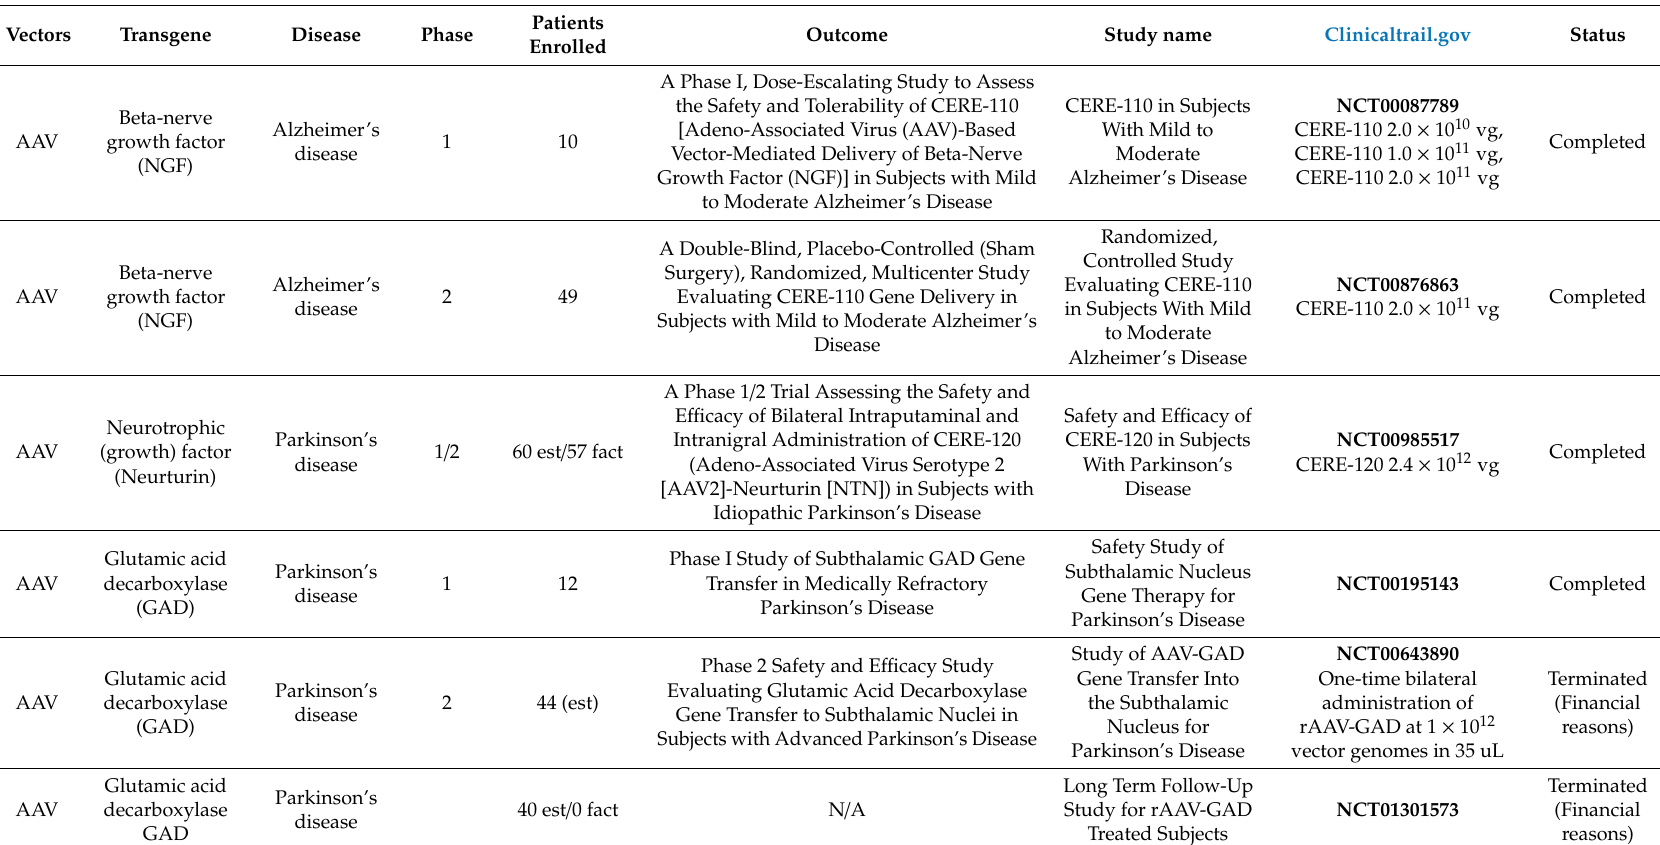
Table 1. Worldwide trials using AAV vectors against neurodegenerative